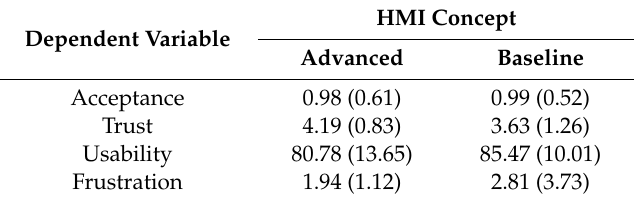
Table 2. Data subset with means (and standard deviations) for subjective